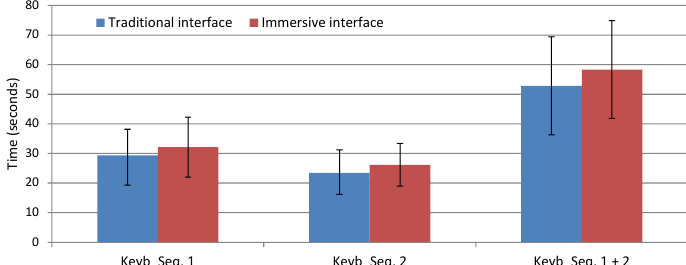
Figure 7. Task 1: mean task-time performance of participants while pressing on a sequence of key blocks determined by the computer: Keyb_Seq. 1 (first round), Keyb_Seq. 2 (second round), and Keyb_Seq. 1+2 (sum of both sequences).